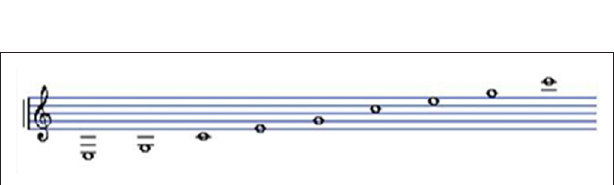
FIGURE 1 | Patient’s facial and intraoral photographs and the lip shield.